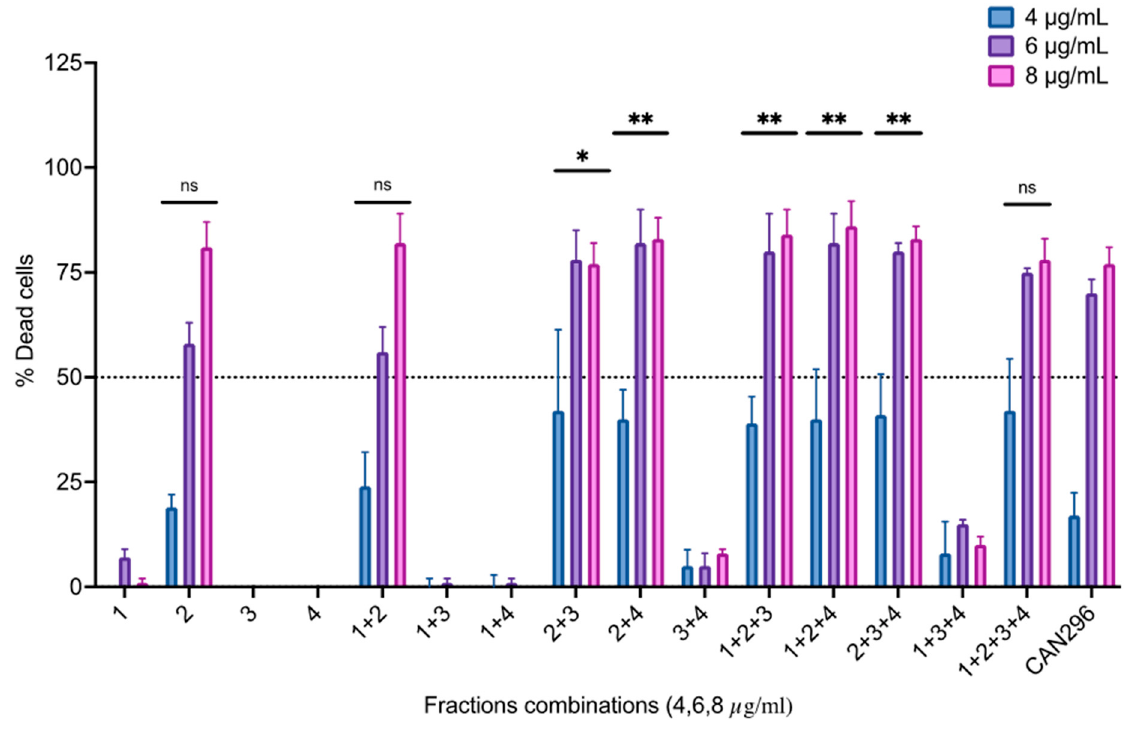
Figure 7. Differential effects of different fraction combinations on the survival of HNSCC cells. The oral Scc25 cell line was treated with 4, 6, and 8 μ g/mL of each fraction or combinations of fractions for 24 h, and cell viability was assessed via MTT assay relative to the DMSO-treated control. Data are reported as mean ± SE (n = 3) of % dead cells out of the total cells. Asterisks represent statistically significant differences compared to CAN296 (* p < 0.05, ** p < 0.01, two-way ANOVA with Dunnett’s multiple comparisons test).